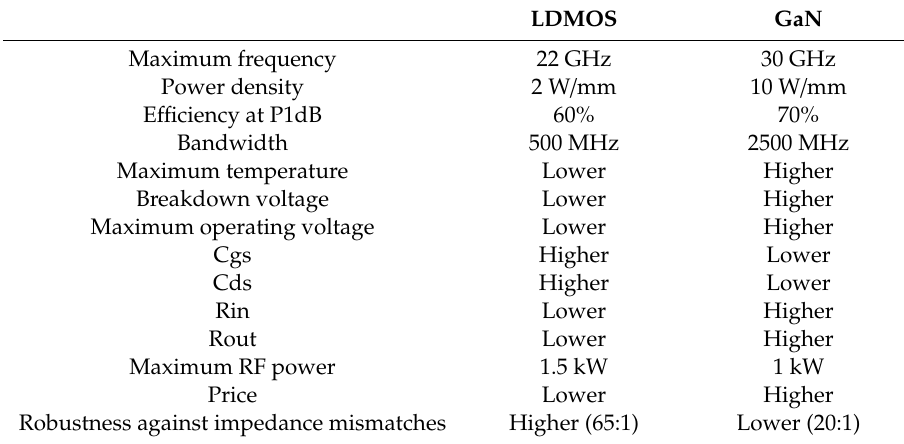
Table 1. Comparison between LDMOS and GaN technologies.